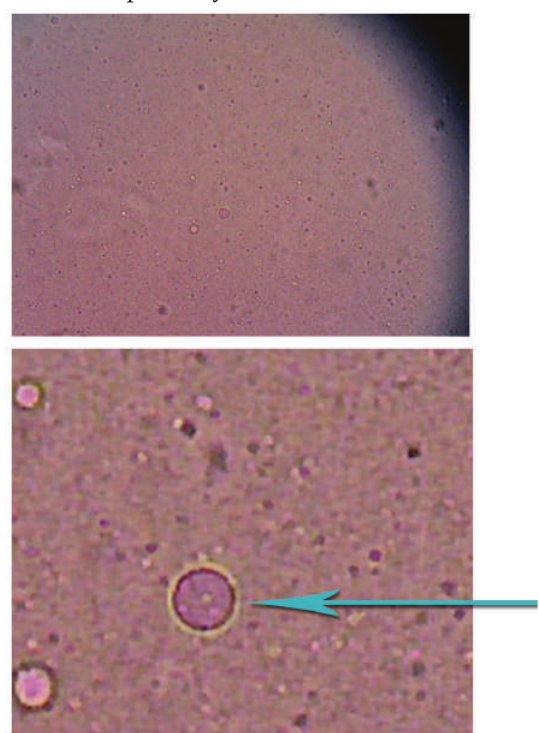
Figure 1. Particle of multiple emulsion of green tea leaf